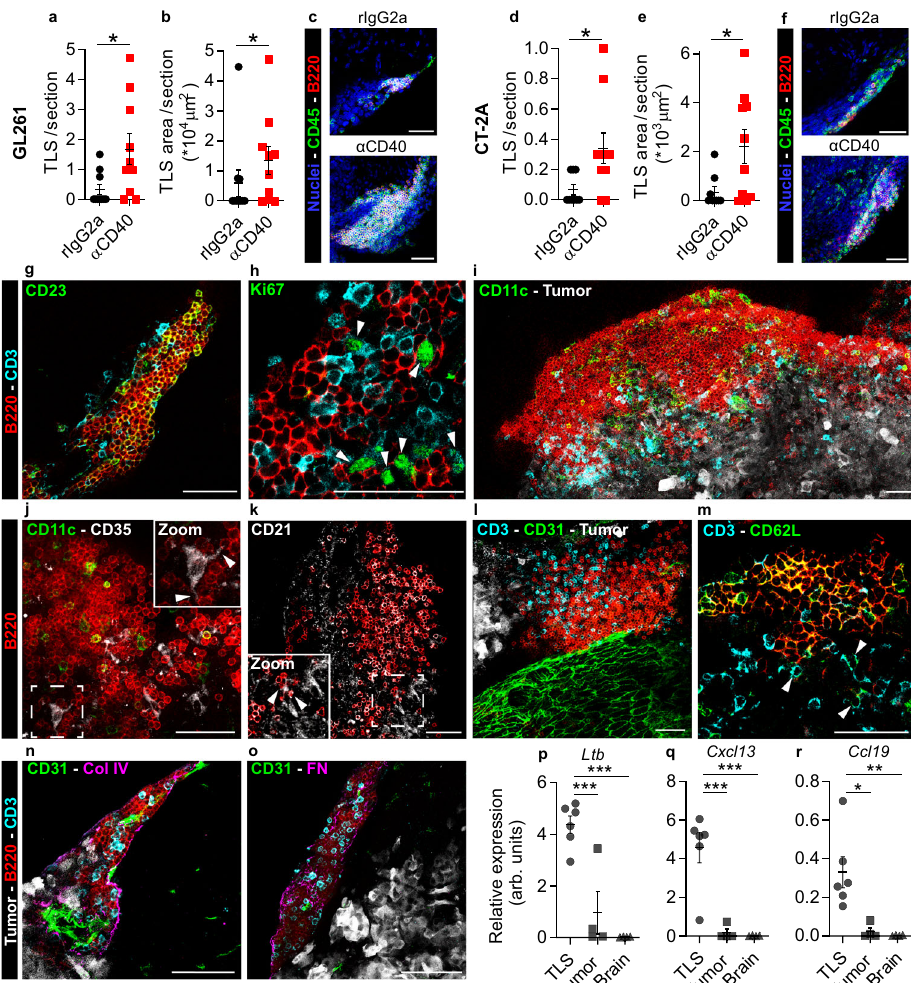
Fig. 1 α CD40 induced formation of tertiary lymphoid structures (TLS) in the brain of GL261 and CT-2A glioma-bearing mice. Quanti fi cation of ( a , d ) the number ( p = 0.0166; p = 0.0106 respectively) and ( b , e ) the total CD45 + surface area ( p = 0.0415; p = 0.0216, respectively) of dense CD45 + B220 + clusters per 80 µ m-thick section, in the brain of GL261 and CT-2A tumor-bearing mice. In a , b , n = 10mice/group. In d , e , n (rIgG2a) = 9 mice, n ( α CD40) = 10 mice. Two-tailed Mann – Whitney test. c , f Representative immuno fl uorescent stainings of the quanti fi ed CD45 + B220 + clusters in the GL261 and CT-2A models. Scale bars: 50 µ m. g – o Immuno fl uorescent stainings of α CD40-induced TLS in the GL261 model showing TLS composition and organization. All images are representative of four independent experiments and 8 mice, and were taken from samples collected at the survival endpoint, between day 23 and day 35 post-tumor implantation (4 – 16 days after the last α CD40 treatment). Arrows in h indicate Ki67 + T cells. Arrows in j indicate dendrites of a CD35 + FDC interacting with surrounding B cells. Arrows in k indicate a CD21 + FDC interacting with surrounding B cells. Scale bars: 50 µ m. p – r Gene expression of TLS-inducing cytokines in laser capture micro-dissected CD45 + B220 + clusters, compared with laser capture micro-dissected tumor tissue and normal brain tissue. arb. units = arbitrary units. n (TLS) = 6 LMD areas, n (tumor) = 4 LMD areas, n (brain) = 4 LMD areas. p p (TLS vs. tumor) = 0.0009, p = 0.0001. q p = 0.0007, p = 0.0005. r p = 0.0115, p = 0.0077. One-way ANOVA with Tukey ’ s (TLS vs. brain) (TLS vs. tumor) (TLS vs. brain) (TLS vs. tumor) (TLS vs. brain) multiple comparison correction. In a , b , d , e , black circle indicates rat IgG2a (rIgG2a) and red square indicates agonistic CD40 antibodies ( α CD40). In p – r , black circle indicates TLS, black square indicates Tumor and black triangle indicates Healthy brain tissue. For all graphs in this fi gure, * p < 0.05, ** p < 0.01, *** p < 0.001. Bars: mean ± SEM. Source data are provided as a Source Data fi